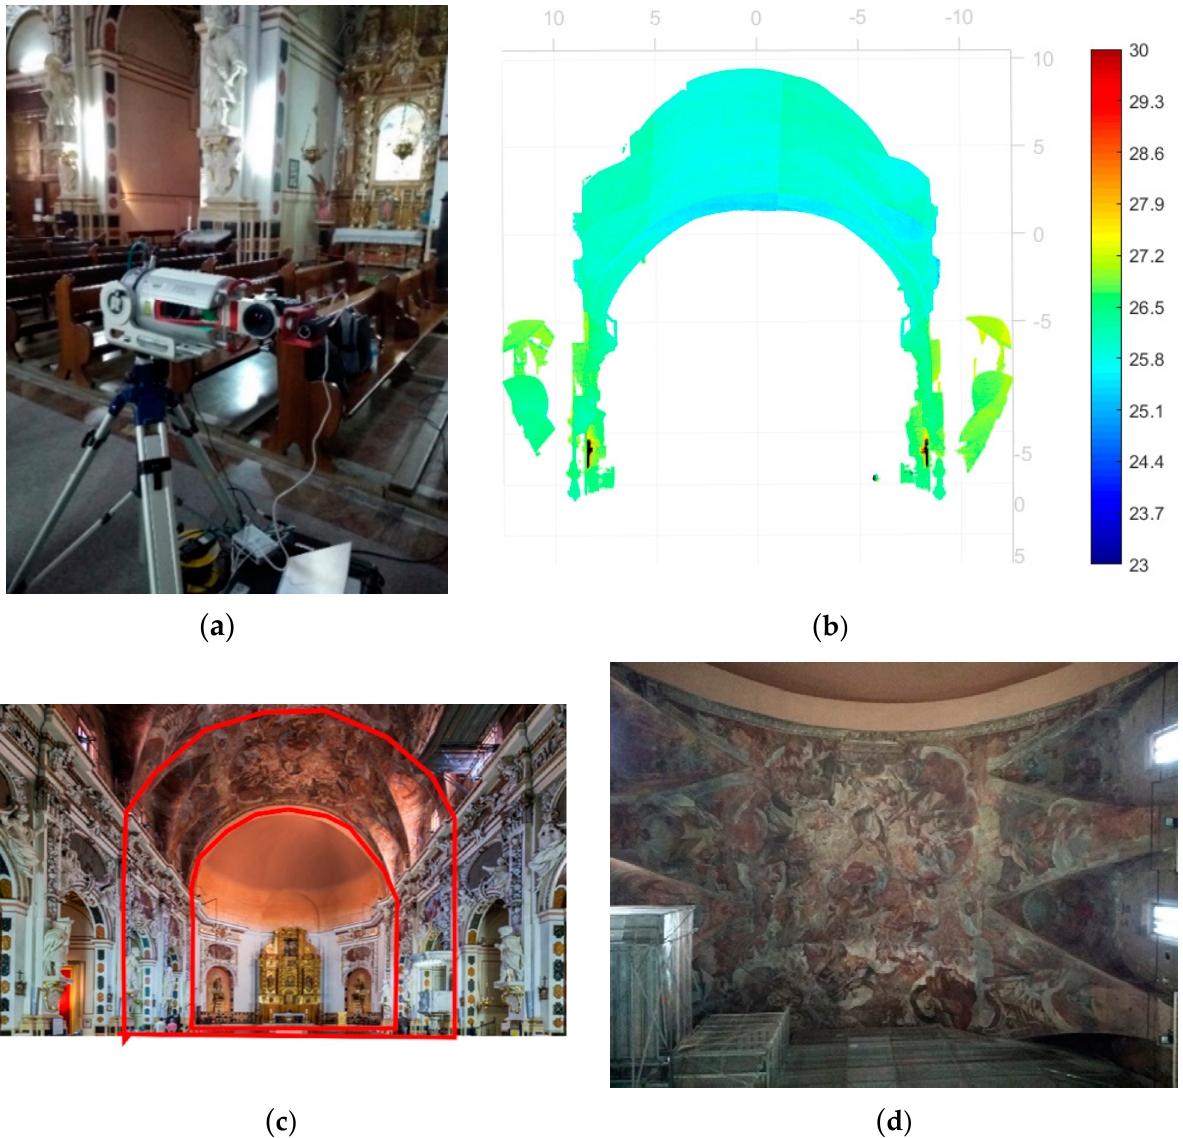
Figure 10. ( a ) The 3D-TCV monitoring system. Riegl 3D-400 scanner coupled with 65A FLIR IR camera. ( b ) Thermal point cloud of Zone 1. ( c ) Region digitised from Position 1. ( d ) A detailed image of the dome.